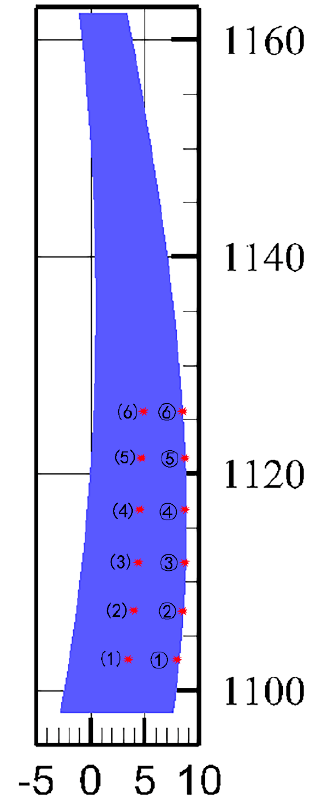
Figure 6. Position distribution of typical points.